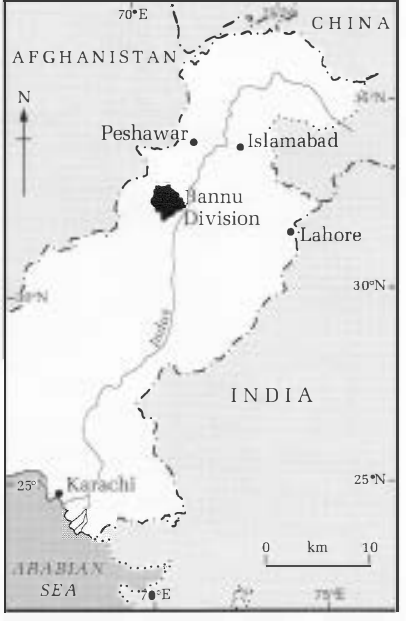
Figure 1 Pakistan, showing the location of Bannu